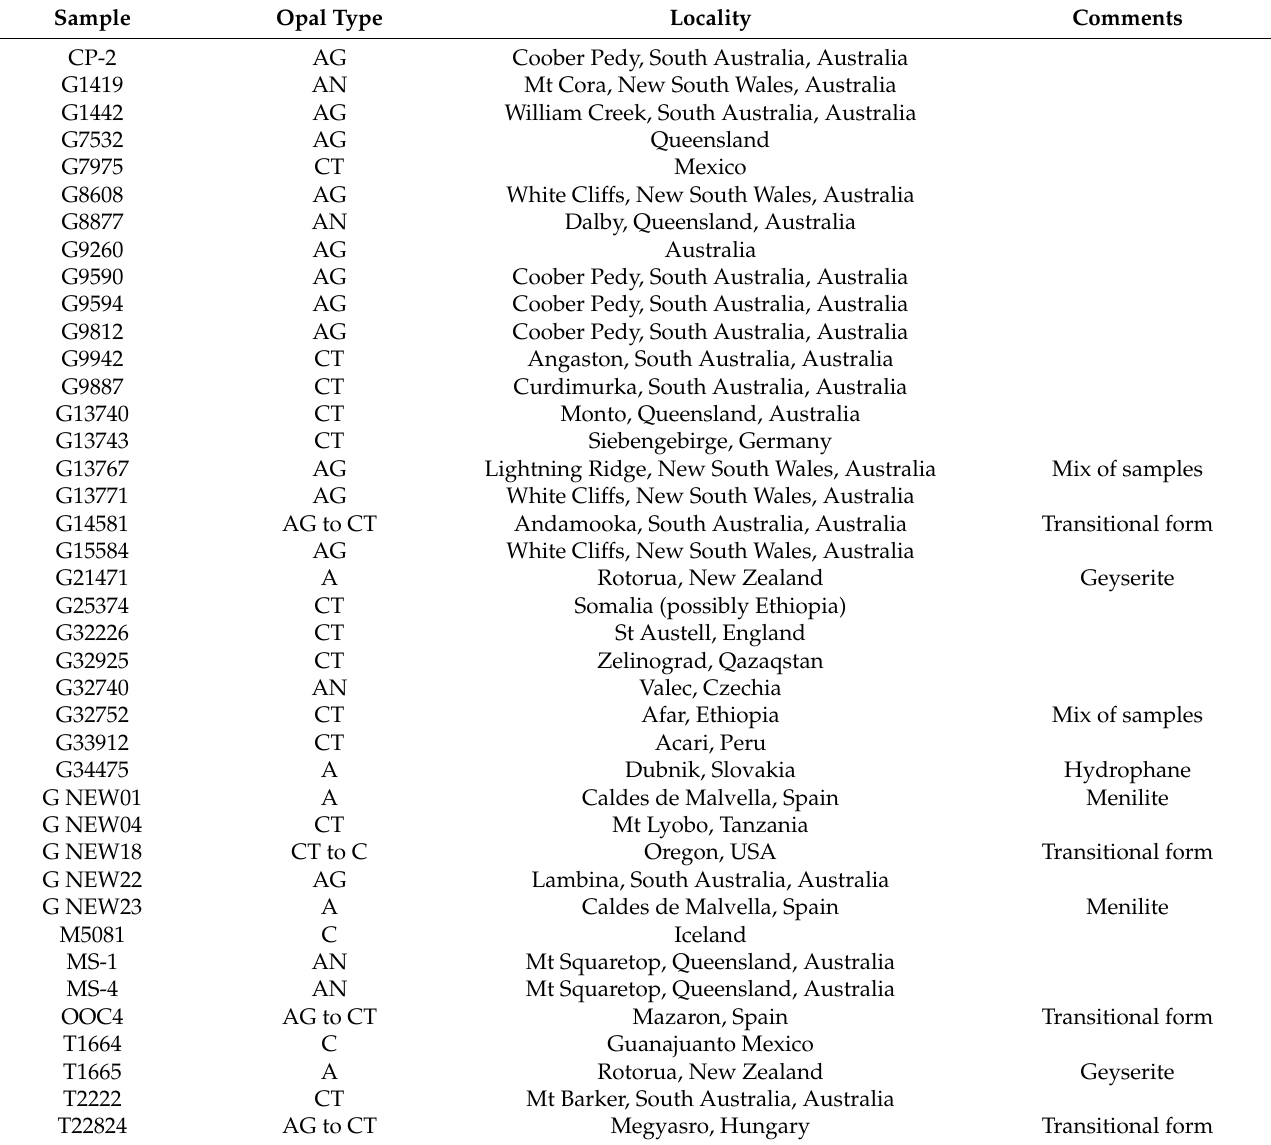
Table 1. Sample locality